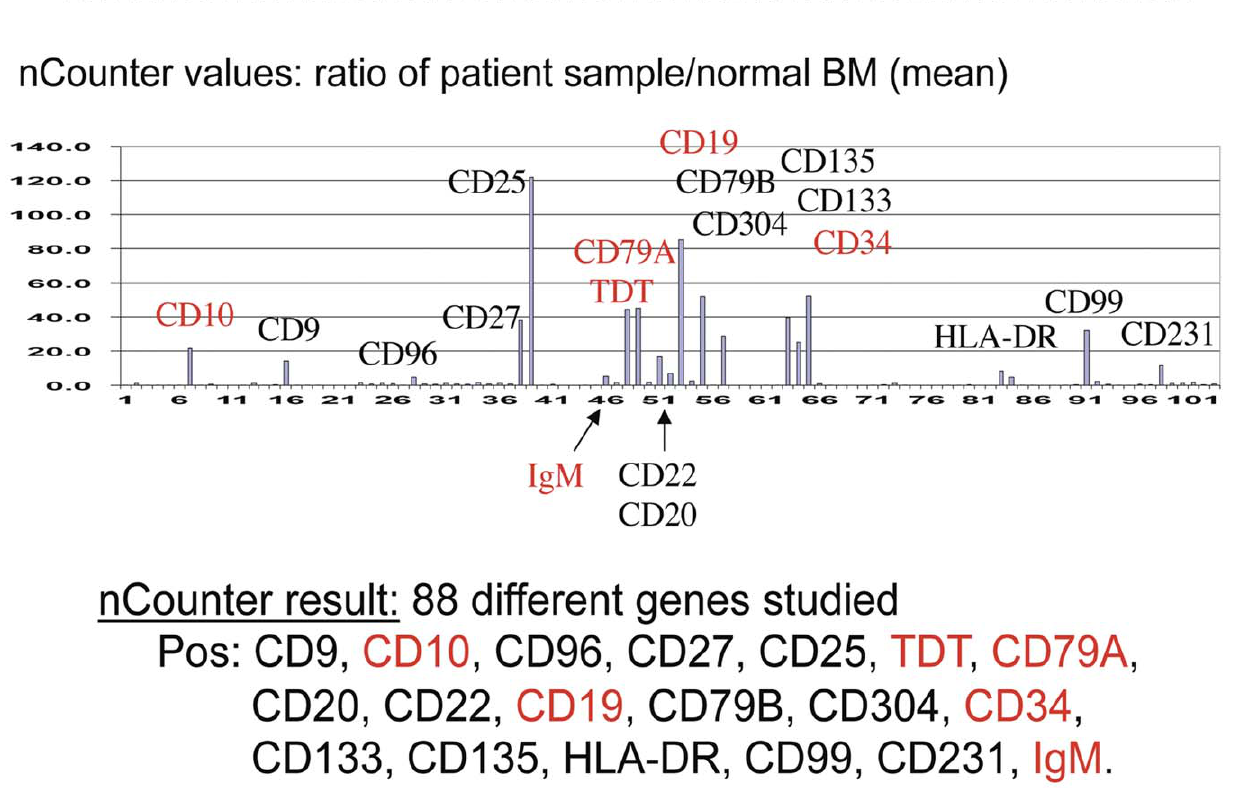
Figure 4. A typical case of B-ALL analyzed in parallel by flow cytometry and by the nCounter technique. Flow cytometry shows the blast population being CD34pos, CD19pos, cy CD79a pos, cy IgM pos, TDT pos, CD10 pos and CD45 pos. In red: antigens found positive with both methods.